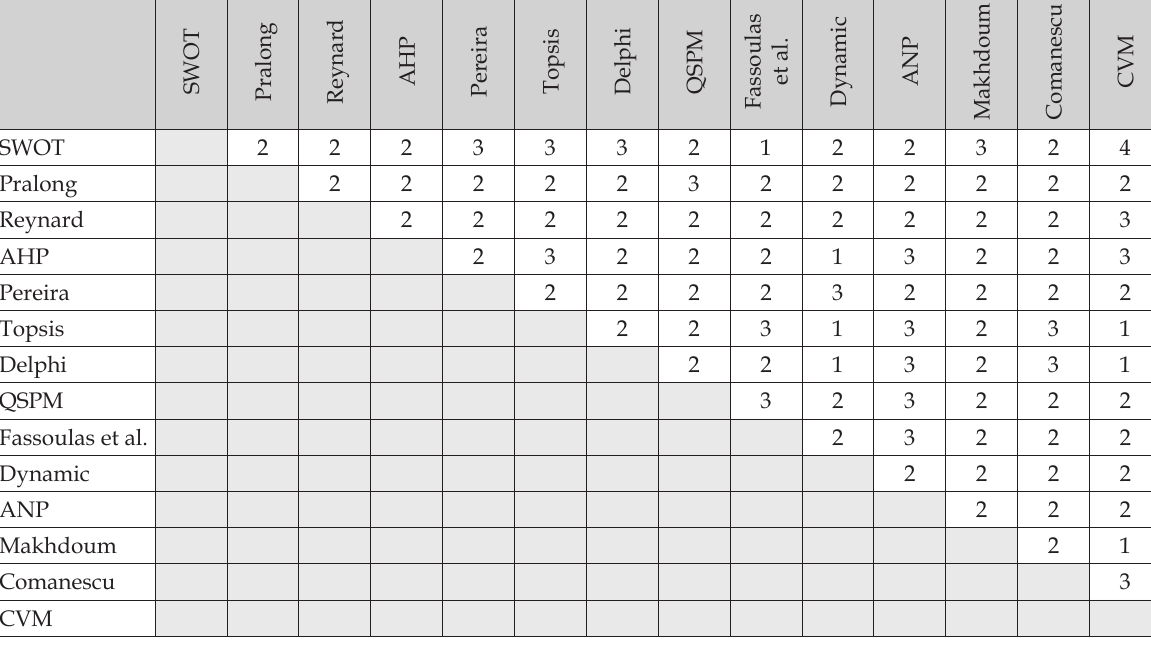
Table 7. The pairwise comparison matrix chart for ‘Fit with the Watershed’ criterion in the expert choice soft- ware environment.